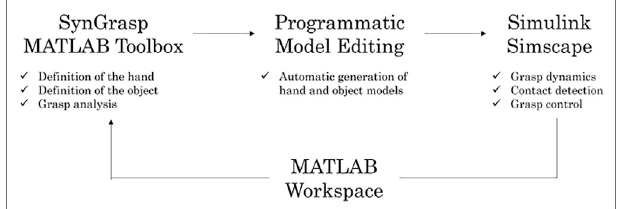
FIGURE 1 | Fundamental components of the proposed